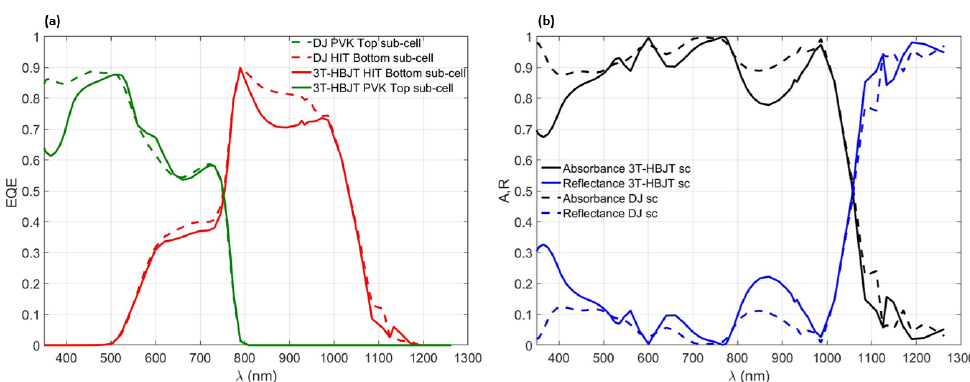
Figure 6. ( a ) External Quantum Efficiency and ( b ) Absorbance and Reflectance for the 3T-HBT (solid line) and 2T-DJ (dashed lines) solar